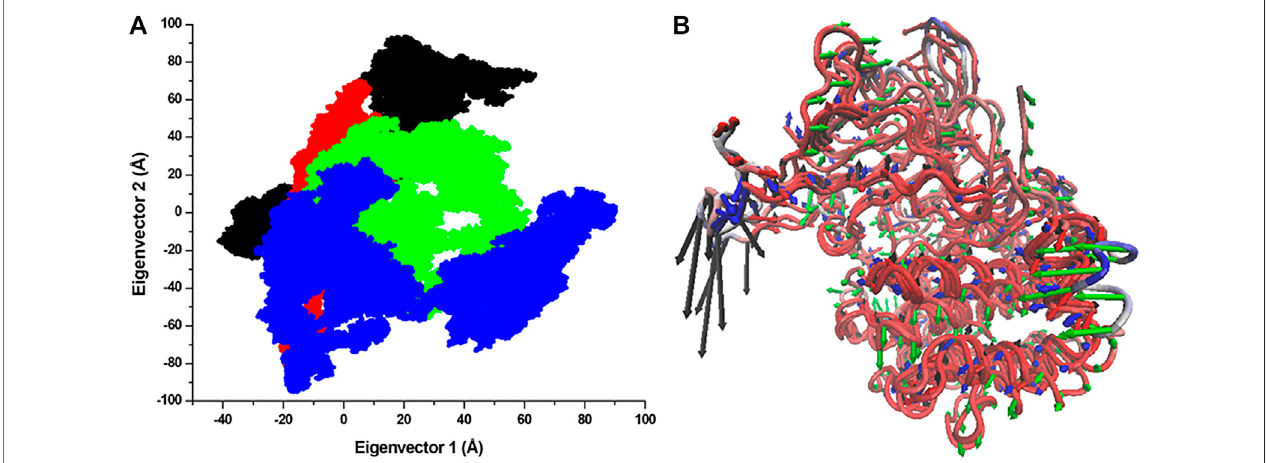
FIGURE 10 | Conformational projection of SGK1 and its mutants. (A) Principal component analysis (PCA) of SGK1 WT (red), K127M (black), T256A (green), and Y298A (blue) mutants calculated after 200 ns of MD trajectories. (B) PC1 collective motions for the obtained predominant eigenvectors using PCA over the 200 ns MD trajectories for SGK1 WT, K127M, T256A, and Y298A mutants of SGK1.